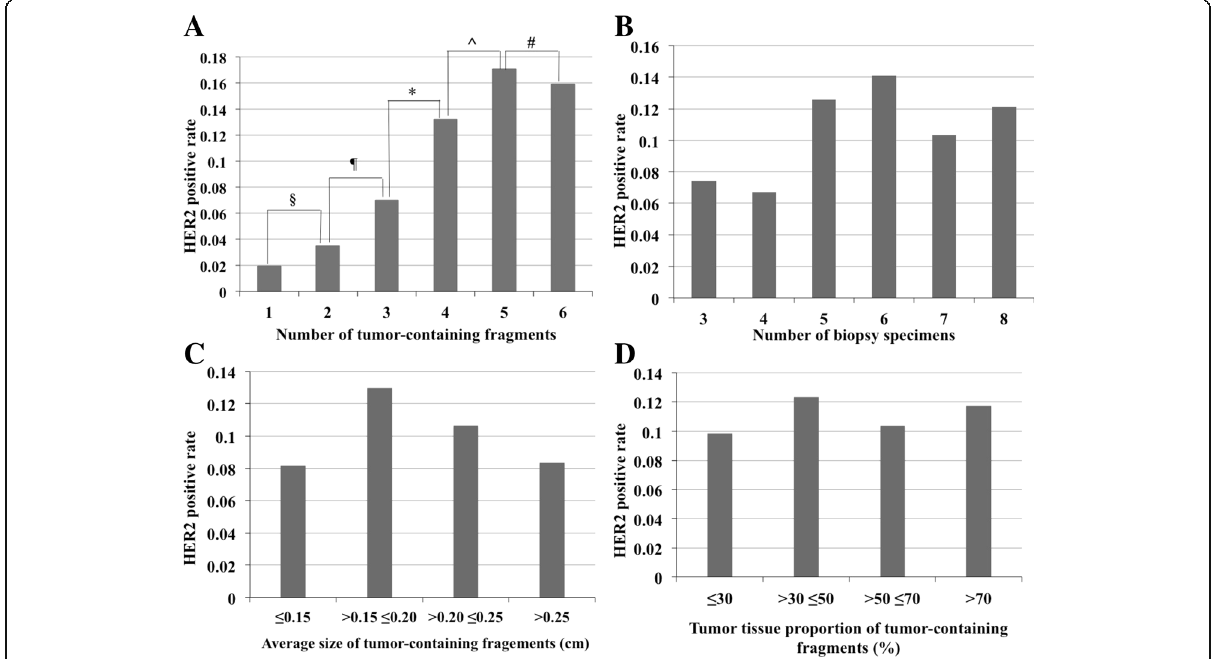
Fig. 2 The associations of HER2 IHC positive (scored 3+) rate with tumor-containing fragment number, biopsy specimen number, average size and tumor tissue proportion of tumor fragments. a The HER2 IHC positive (scored 3+) rate exhibited elevation with increased tumor fragment numbers ( P =0.004). The rates of 1, 2, 3, 4, 5 and 6 fragments were 2.0, 3.5, 7.0, 13.2, 17.1, and 15.9%. The 4-fragment subgroup showed a much higher HER2 IHC positive rate than the 3-fragment subgroup. No statistical difference is reached among subgroups with 4, 5 and 6 fragments. § P =0.6, ¶ P =0.263, * P =0.035, ^ P =0.299, # P =0.812. b HER2 IHC positive (scored 3+) rates were 7.4, 6.7, 12.6, 14.1, 10.3, and 12.1% when the biopsy number was 3, 4, 5, 6, 7, and 8 respectively without significant differences ( P =0.127). c HER2 3+ rates of the subgroups divided based on average size of tumor fragments were 8.2, 12.9, 10.7 and 8.3% without statistical difference ( P =0.397). d HER2 3+ rates of subgroups divided based on tumor tissue proportion of tumor fragments were 9.8, 12.3, 10.4 and 11.7% ( P =0.825)